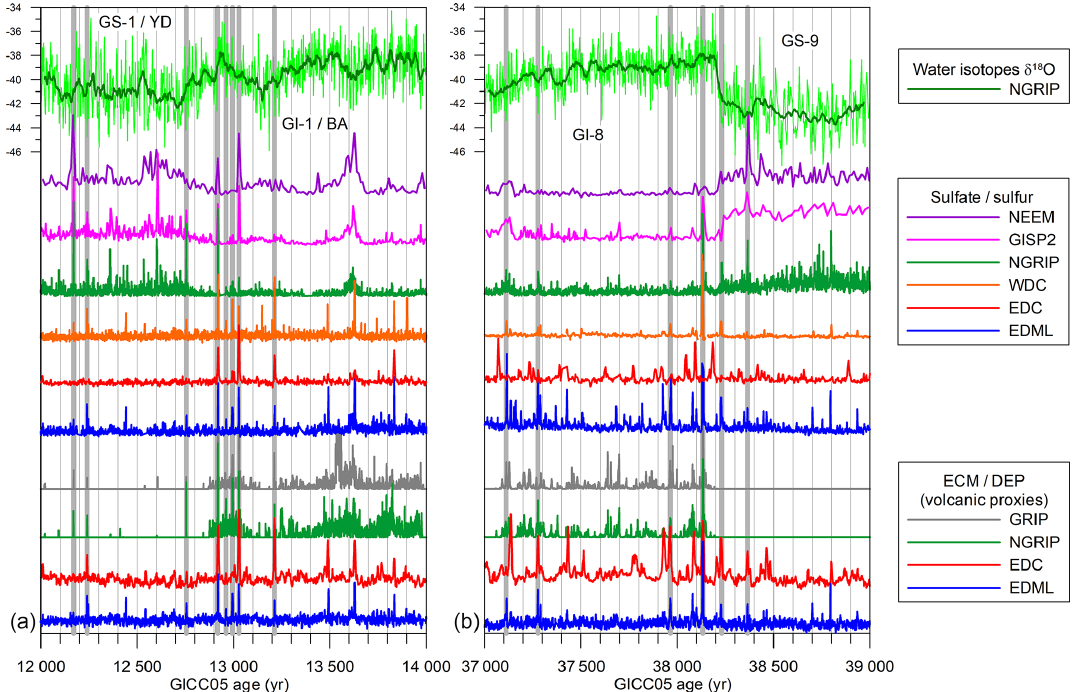
Figure 2. Bipolar volcanic synchronization of the investigated ice cores across the transition from GI-1/Bølling–Allerød (BA) to GS- 1/Younger Dryas (YD) (a) and the onset of GI-8 (b) . Grey vertical lines are bipolar volcanic match points (Table S2). The records have different units; some are uncalibrated and peak heights are not comparable on an absolute scale, which is the reason why no scales are